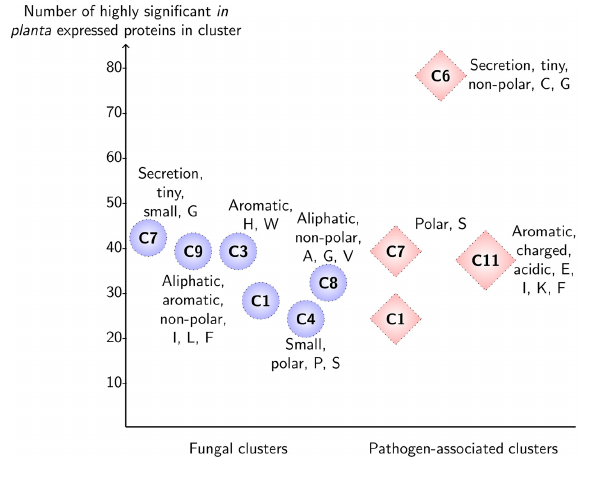
FIGURE 3 | Highly significant in planta expression for predicted clusters of the fungal gene families and pathogen-associated gene families in wheat stem rust. For each cluster, the enriched sequence-derived features and number of highly significant up-regulated genes are shown ( p < 0 . 00001). Note that for clarity, only clusters which have more than 20 up-regulated proteins are shown. The pathogen-associated cluster C6 sits at the top with 78 proteins that are up-regulated with high significance and has enrichment in features that are associated with effector proteins (secreted, small size, cysteine-rich).